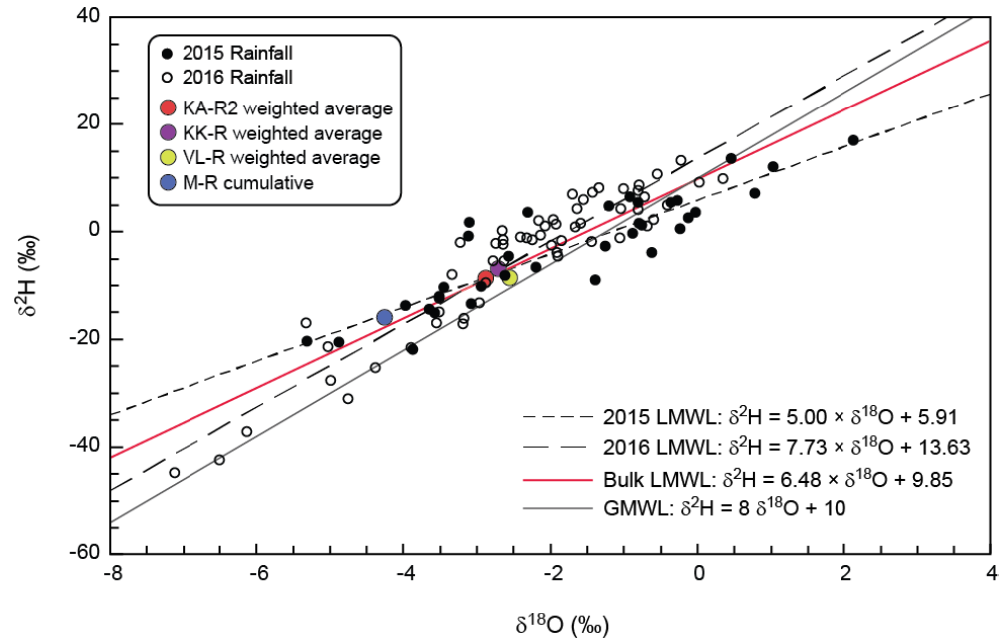
Figure 6. δ 18 O vs. δ 2 H plot showing distribution of rainwater samples and slope of local meteoric water lines defined for both 2015 and 2016 as well a combined local meteoric water line. The weighted averages for the rainwater collectors over the sampling period are also shown. LMWL: local meteoric water line; GMWL: global meteoric water line.